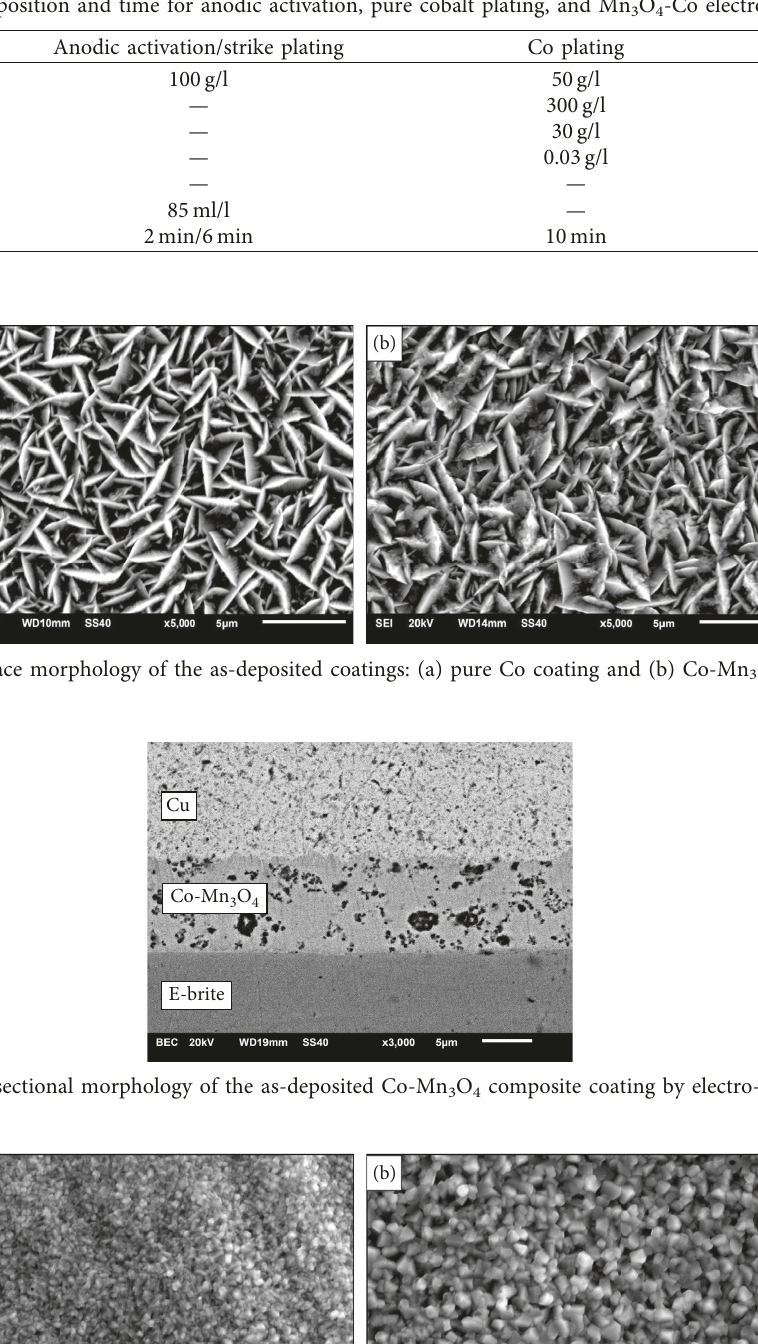
Figure 3: Surface morphology of the pure Co layer after oxidation for different times: (a) 10min and (b) 4